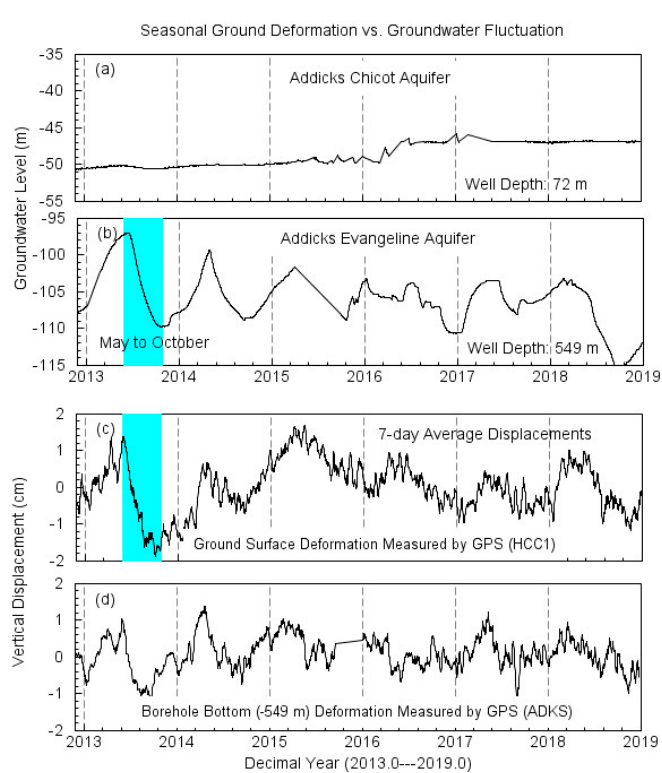
Figure 16. Plots depicting the coincidence of the seasonal ground surface up and down with the fluctuations of the Evangeline groundwater level. (a) The history of groundwater level in the Chicot aquifer at Addicks site; (b) the history of the groundwater level in the Evangeline aquifer; (c) the vertical displacements at the land surface recorded by HCC1; (d) the vertical displacements at the bottom of the borehole (549 m below the land surface) recorded by the deep-mounted GPS antenna